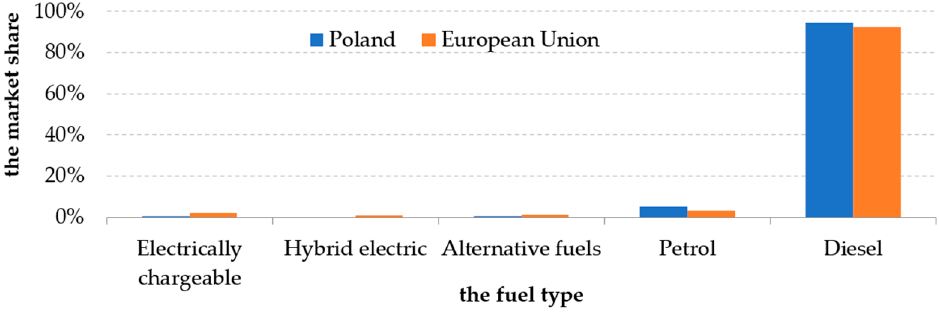
Figure 11. Market share of new light commercial vehicles (up to 3.5 t) by fuel type in 2020 [20].